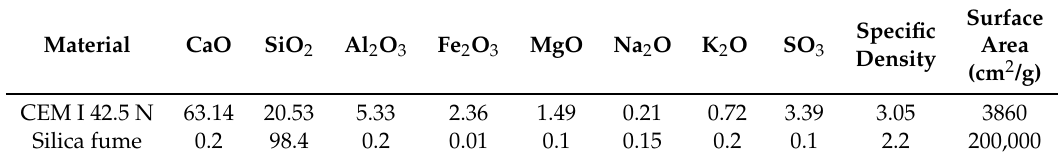
Table 1. Chemical and physical properties of cement and silica fume given by the manufacturer (wt %).